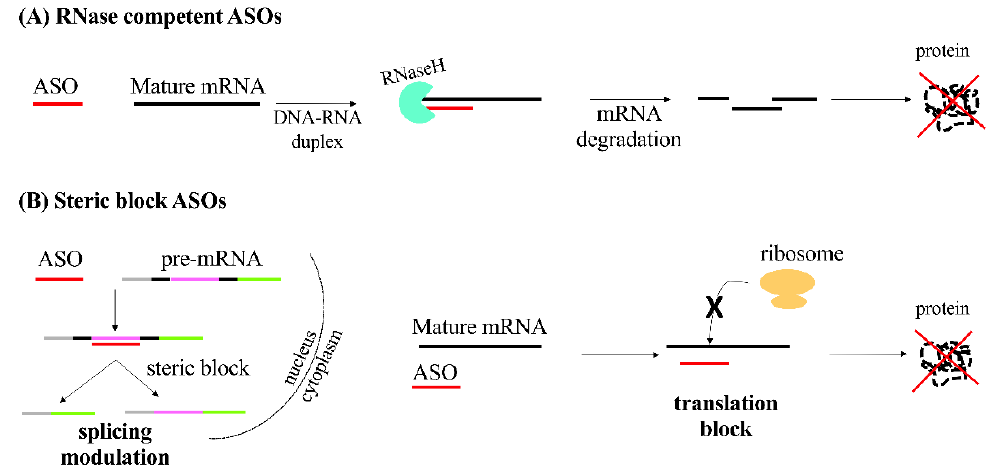
Figure 1. Therapeutic ASOs. Schematic representation of the mechanism of action of antisense oligonucleotides (ASOs) ( A ) RNase competent and ( B ) steric block. mRNA: messenger RNA.